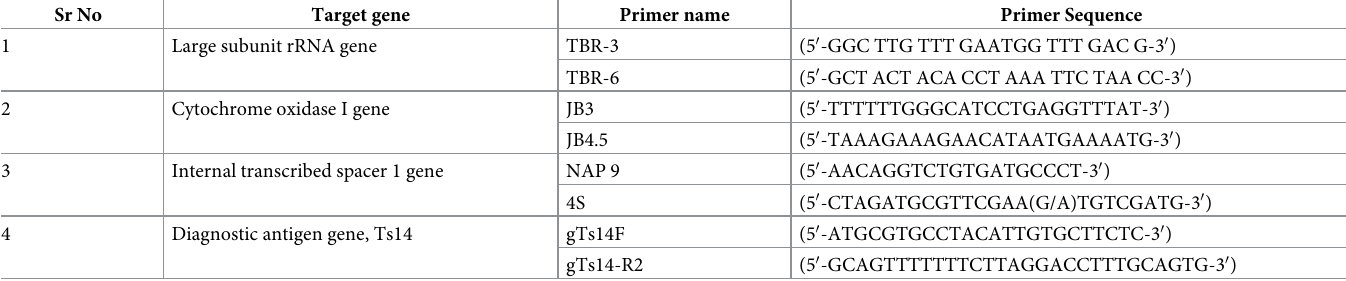
Table 1. Oligonucleotide primers used for detection of T . solium cysts from naturally infected pigs in Punjab, India. Sr